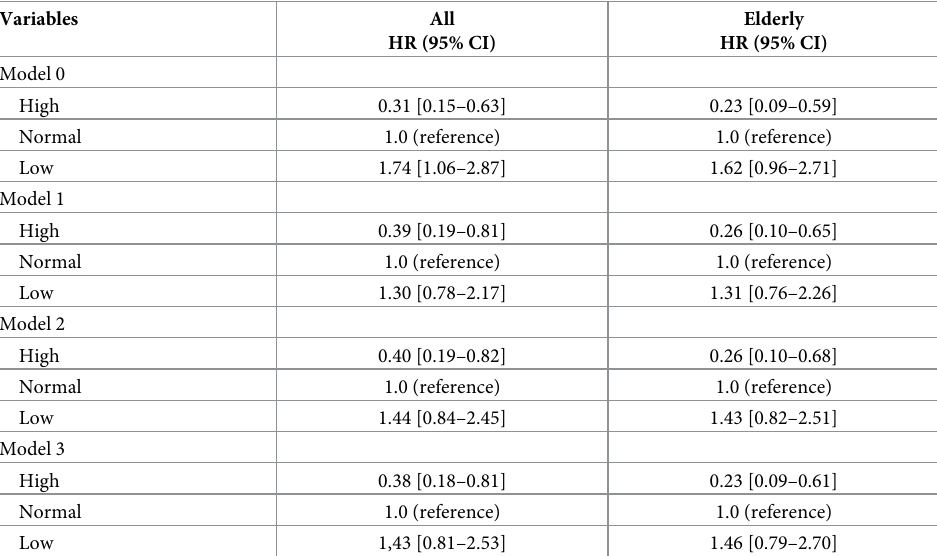
Table 4. Hazard ratio of BMI category by multivariate Cox regression analysis for all-cause mortality in all HD patients and elderly ( � 65 years) HD patients at 2 weeks after HD initiation.